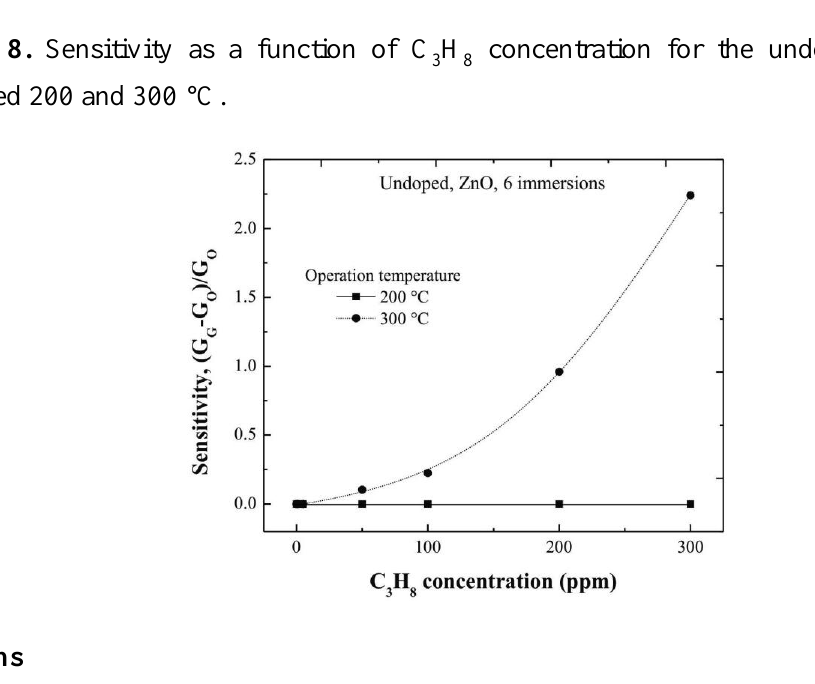
H concentration for the undoped ZnO film 3 8